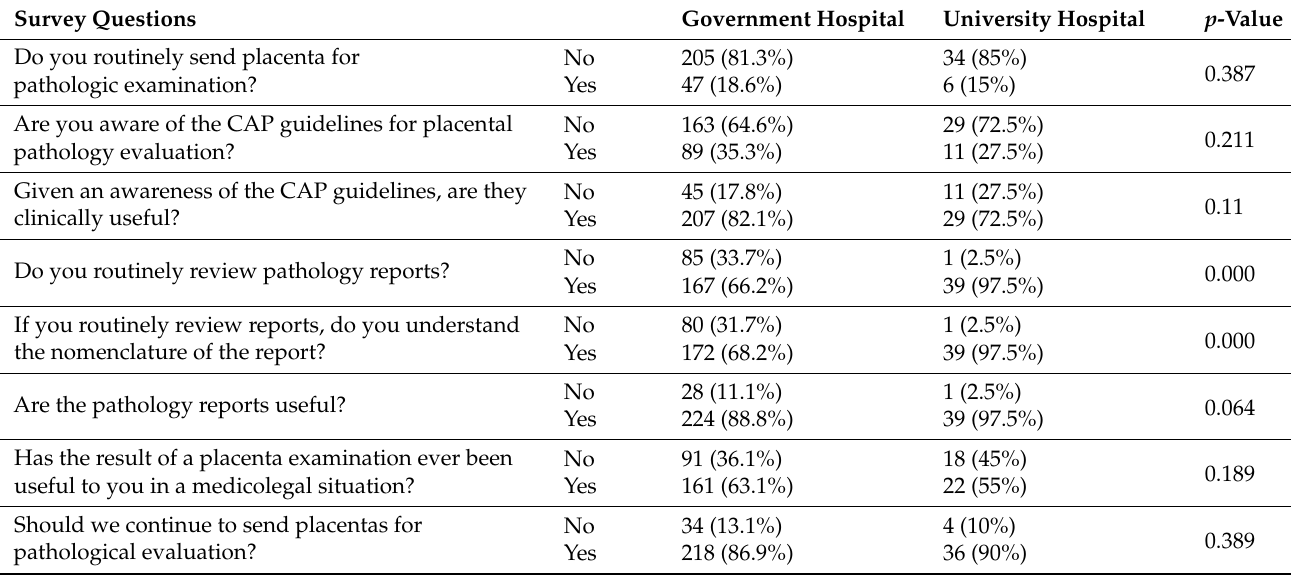
Table 4. Bivariate analysis comparing the responses to the survey questions across different